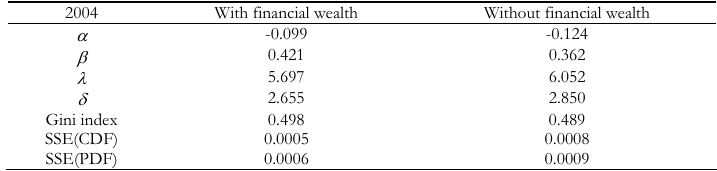
Dagum model estimates for human capital distribution in Italy, 2004, with and without financial wealth 2004 With financial wealth Without financial wealth